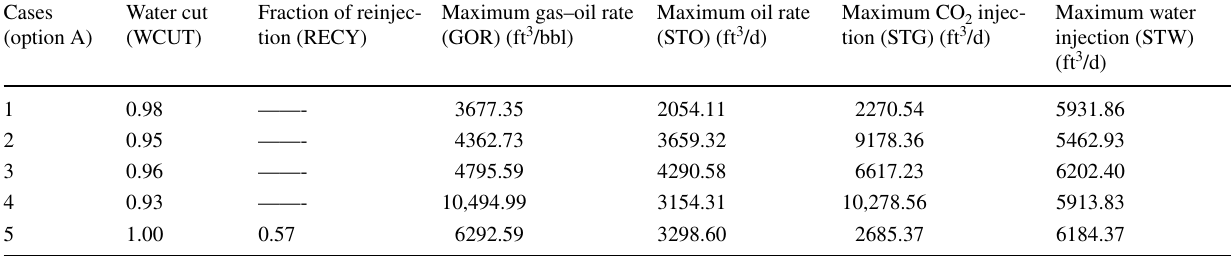
Table 15 Results of the optimized values of each case in option A Cases (option A)